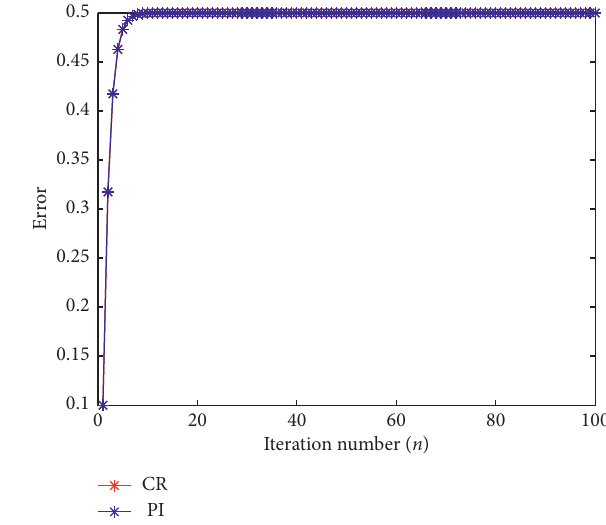
Figure 1: Errors versus iteration numbers ( n ): Example 1 (Case 1).